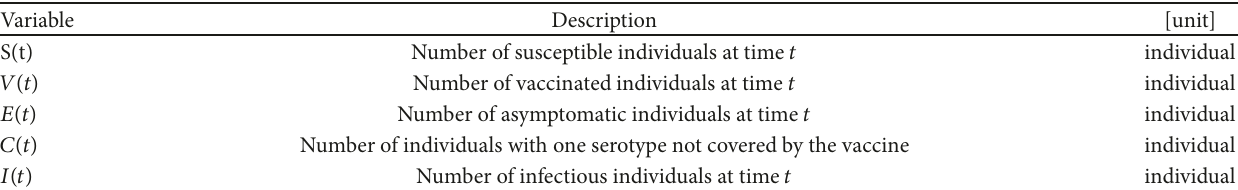
Table 1: Description of